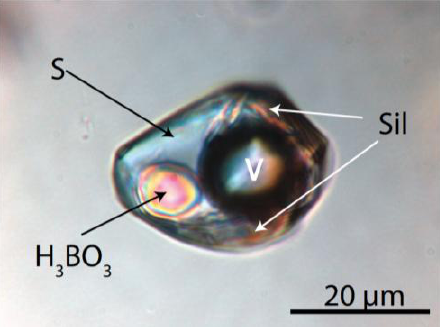
= 282.5 ± 13°C) the H and a H O-rich 2 2